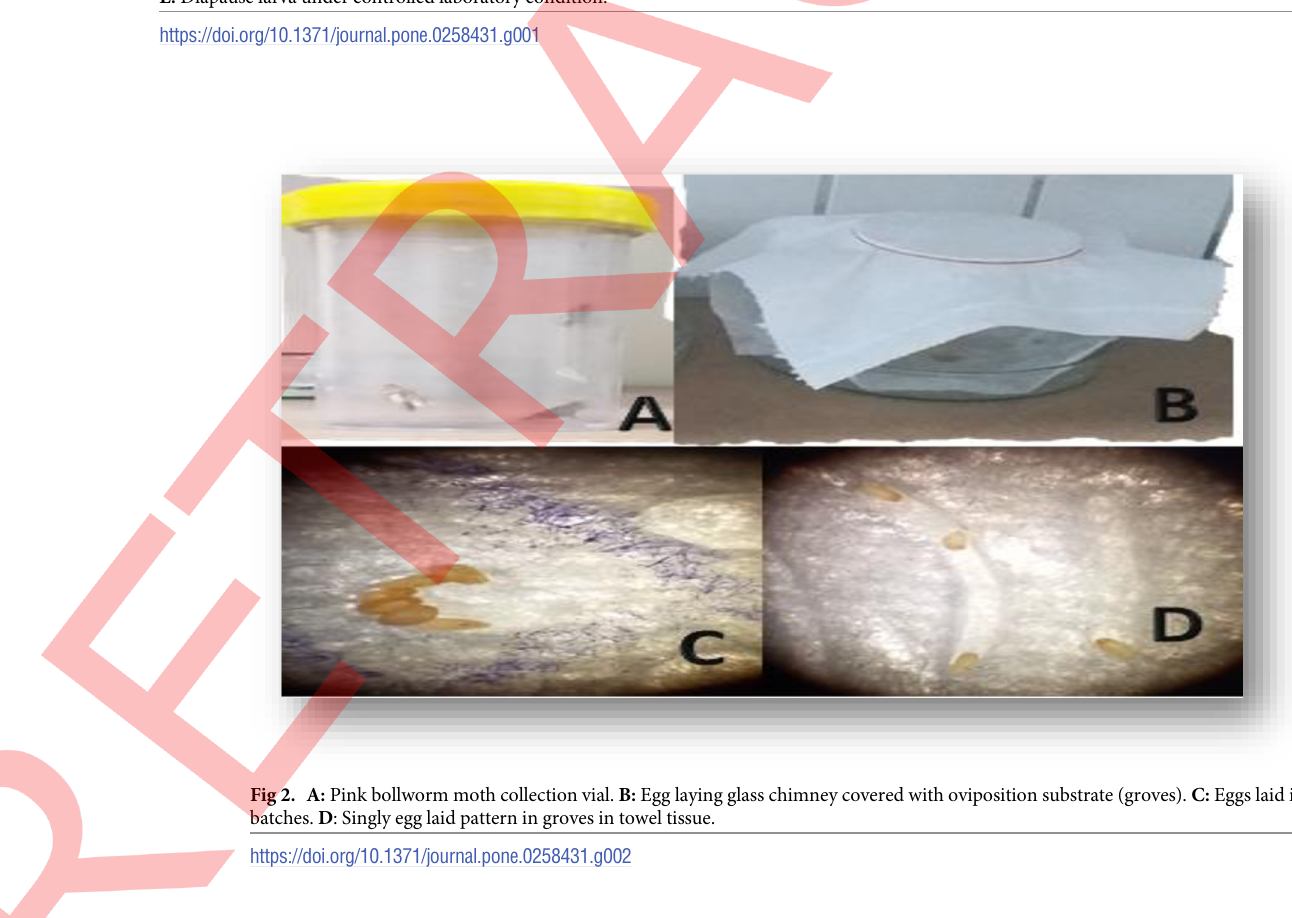
PLOS ONE | https://doi.org/10.1371/journal.pone.0258431 November11,